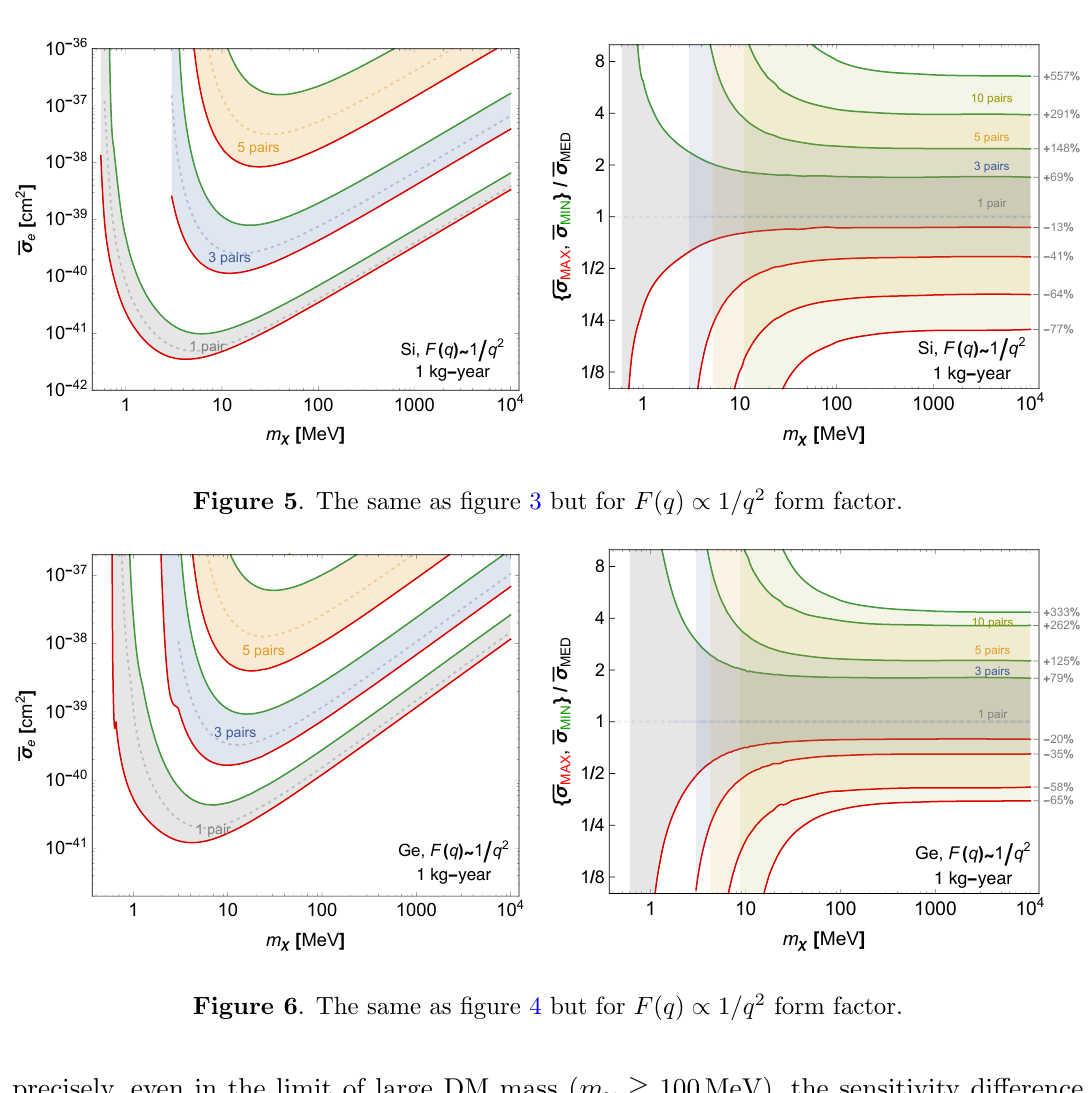
Figure 6 . The same as (cid:12)gure 4 but for F ( q )